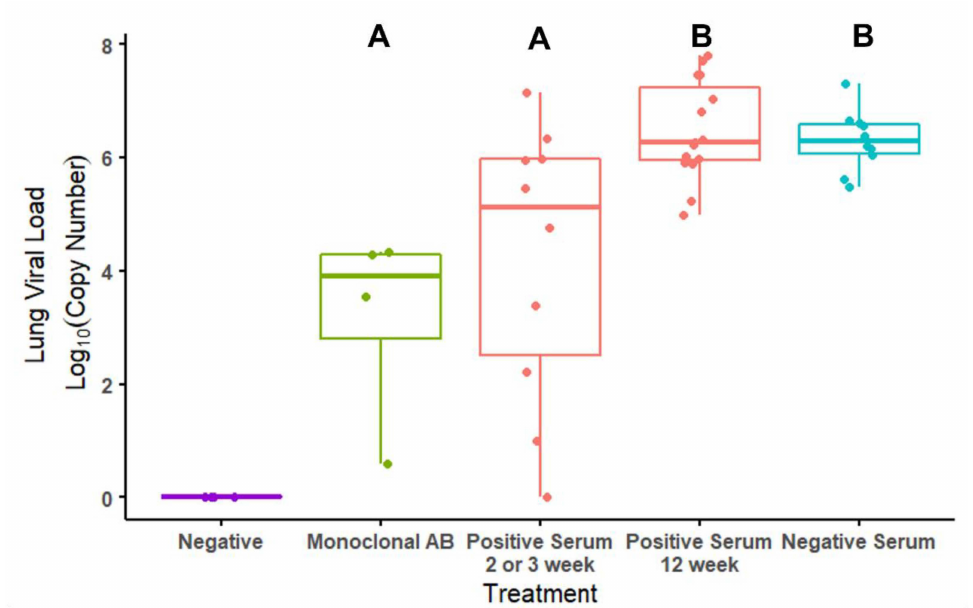
Figure 4. Quantitative log 10 viral loads from the right lung of mice challenged with SARS-CoV-2 by treatment. Treatment indicates whether mice received a serum transfer from vaccinated (positive serum—either 2–3 weeks or 12 weeks post-boost; shown in red) BFF, unvaccinated (negative serum; shown in blue), or a monoclonal anti-S1 antibody (monoclonal AB; shown in green) prior to challenge. Negative treatment represents a negative control (shown in purple). These mice were given a placebo challenge. Each point represents an individual mouse. Different letters represent which groups significantly differ from each other ( p ≤ 0.05).